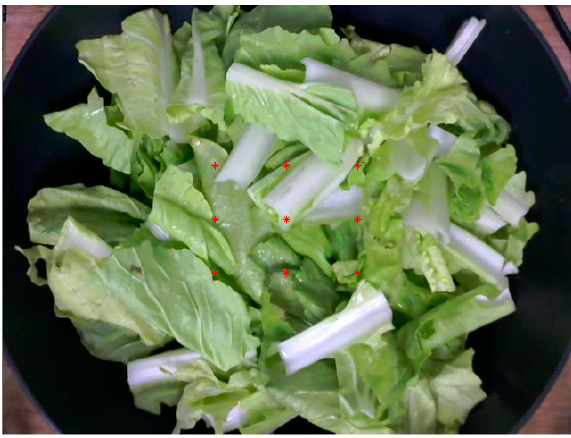
Figure 8. Image of uncooked cabbage and nine marking points.